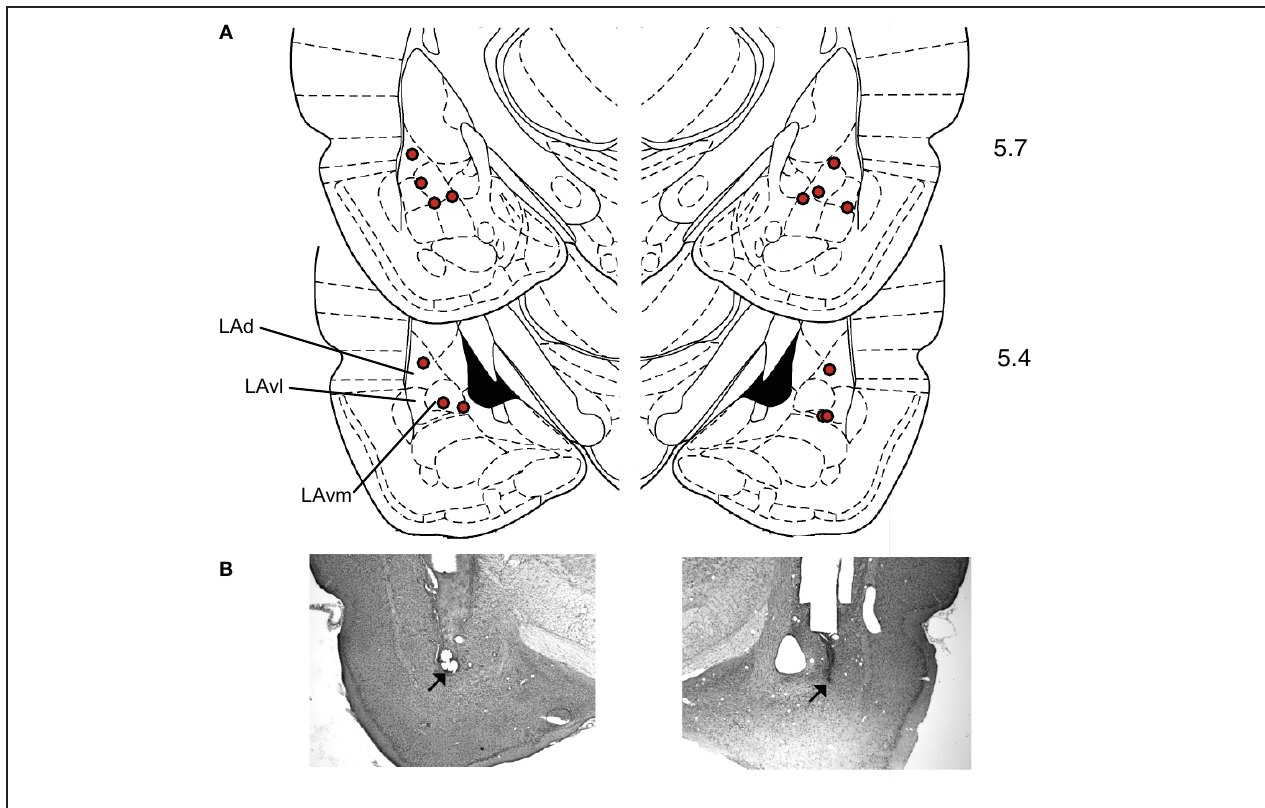
FIGURE 5 | Histological verification of cannula placements in the LA. (A) Rats were implanted bilaterally with 22-gauge stainless steel guide cannulae that terminated 1.5mm above the target location in the LA. The target location coordinates, taken from Paxinos and Watson (2004), were + 5.7 anteroposterior, ± 5.3 mediolateral, and + 2.0mm dorsoventral with reference to inter-aural zero. Locations of cannula tip